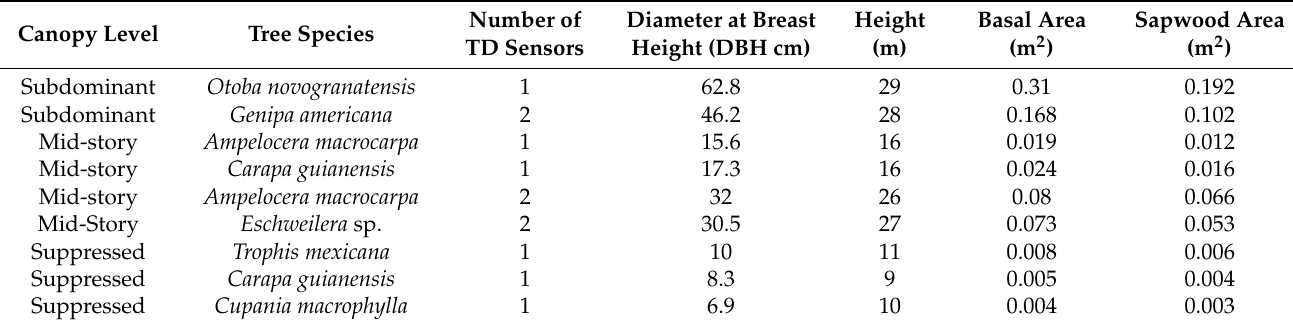
Table 1. Plant descriptions of the three suppressed, four mid-story, and two subdominant trees sampled. Tree measurements taken from Aparecido, Miller, Cahill and Moore